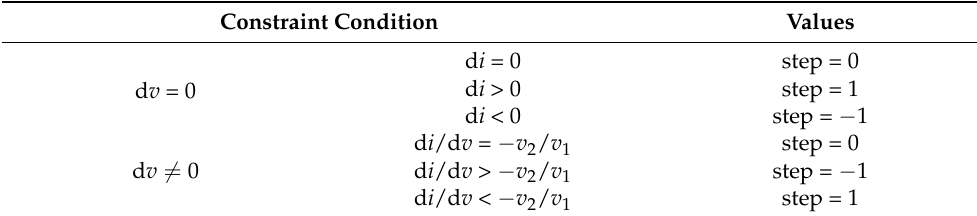
Figure 5. Variable step INC flow chart. In Figure 5, the duty cycle is D, and the change of each duty cycle is ∆ D = K × step, where K = n × abs (d p /d v ), n is a constant, n = 0.0002. The value of step is shown in Table 1: Table 1. Value table of